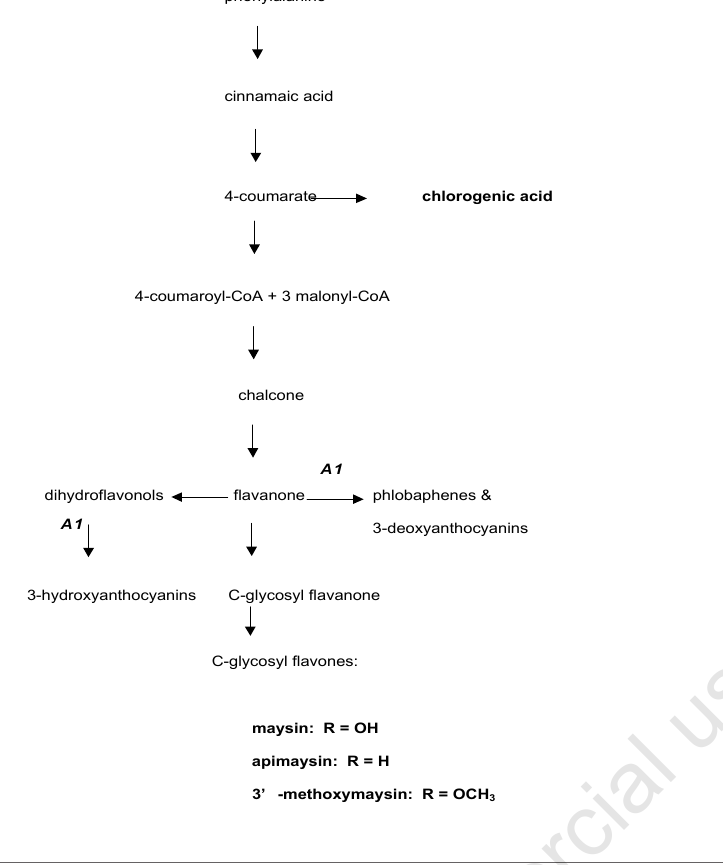
Figure 1. A schematic part of the flavonoid and phenylpropanoid pathways (adopted from Guo et al. , 2004) leading to antibiotic compound biosynthesis in maize silks: inter- mediates, competing branch pathways, and the structures of chlorogenic acid and C-gly- cosyl flavones including maysin, apimaysin, and methoxymaysin. Functional A1 allele of a1 gene encodes for a dihydroflavonol 4-reductase (Bernhardt et al. , 1998), which is involved in two branches of the